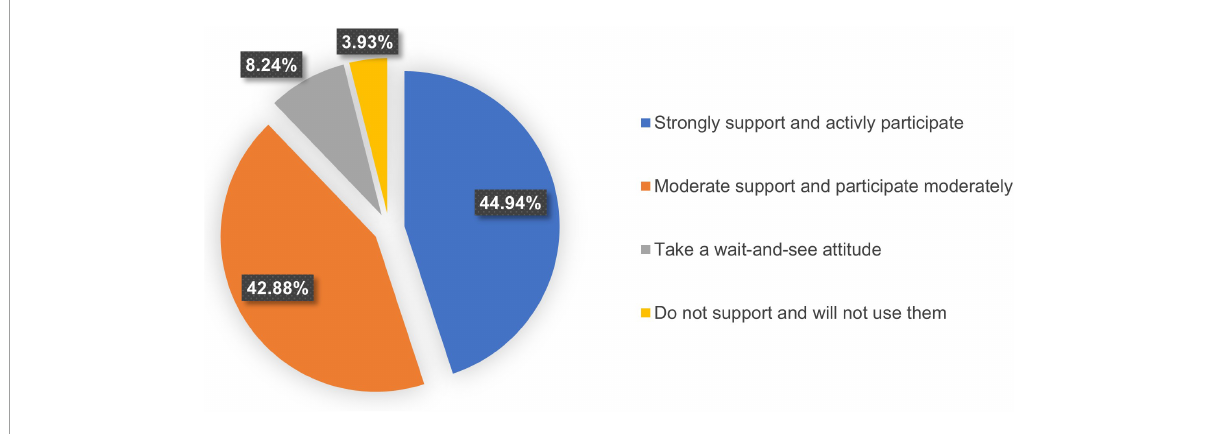
FIGURE4 Pediatricians’ attitudes toward internet hospitals